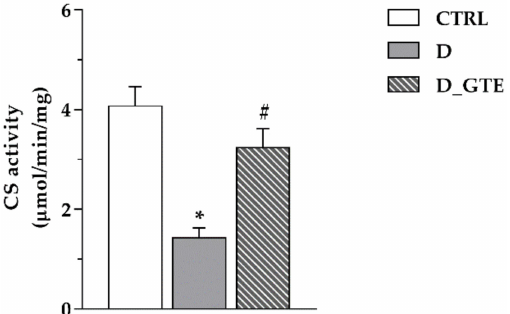
Figure 3. Citrate synthase activity of CTRL, D and D_GTE reported as µ mol/min/mg. Histograms show the mean ± SEM. * p < 0.05 significant differences vs. CTRL; # p < 0.05 significant differences vs. D (Kruskal–Wallis